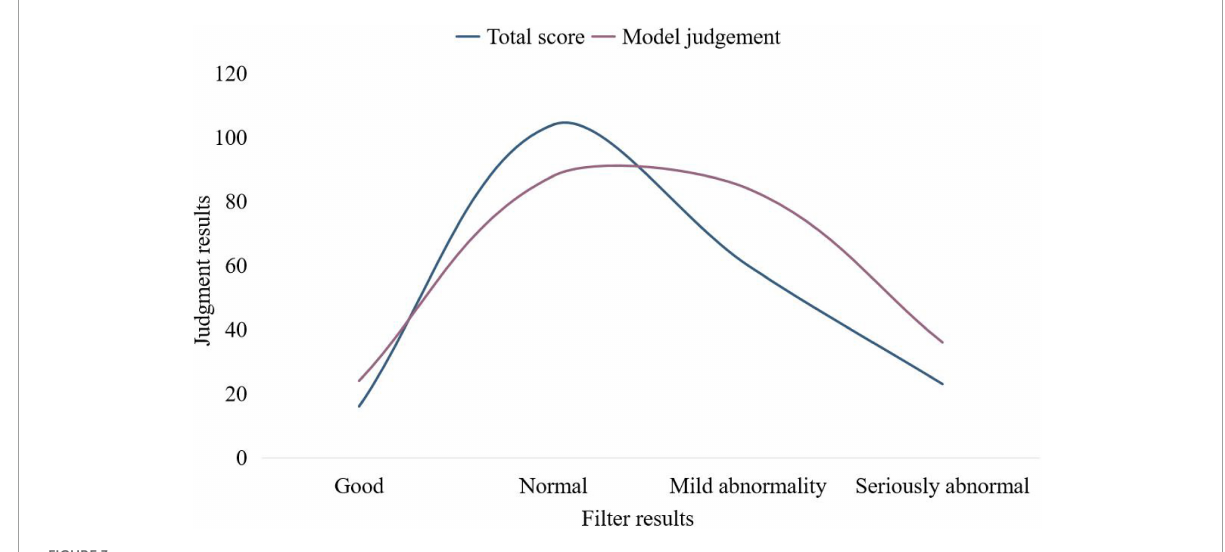
FIGURE3 Comparison of screening results of fuzzy comprehensive evaluation.